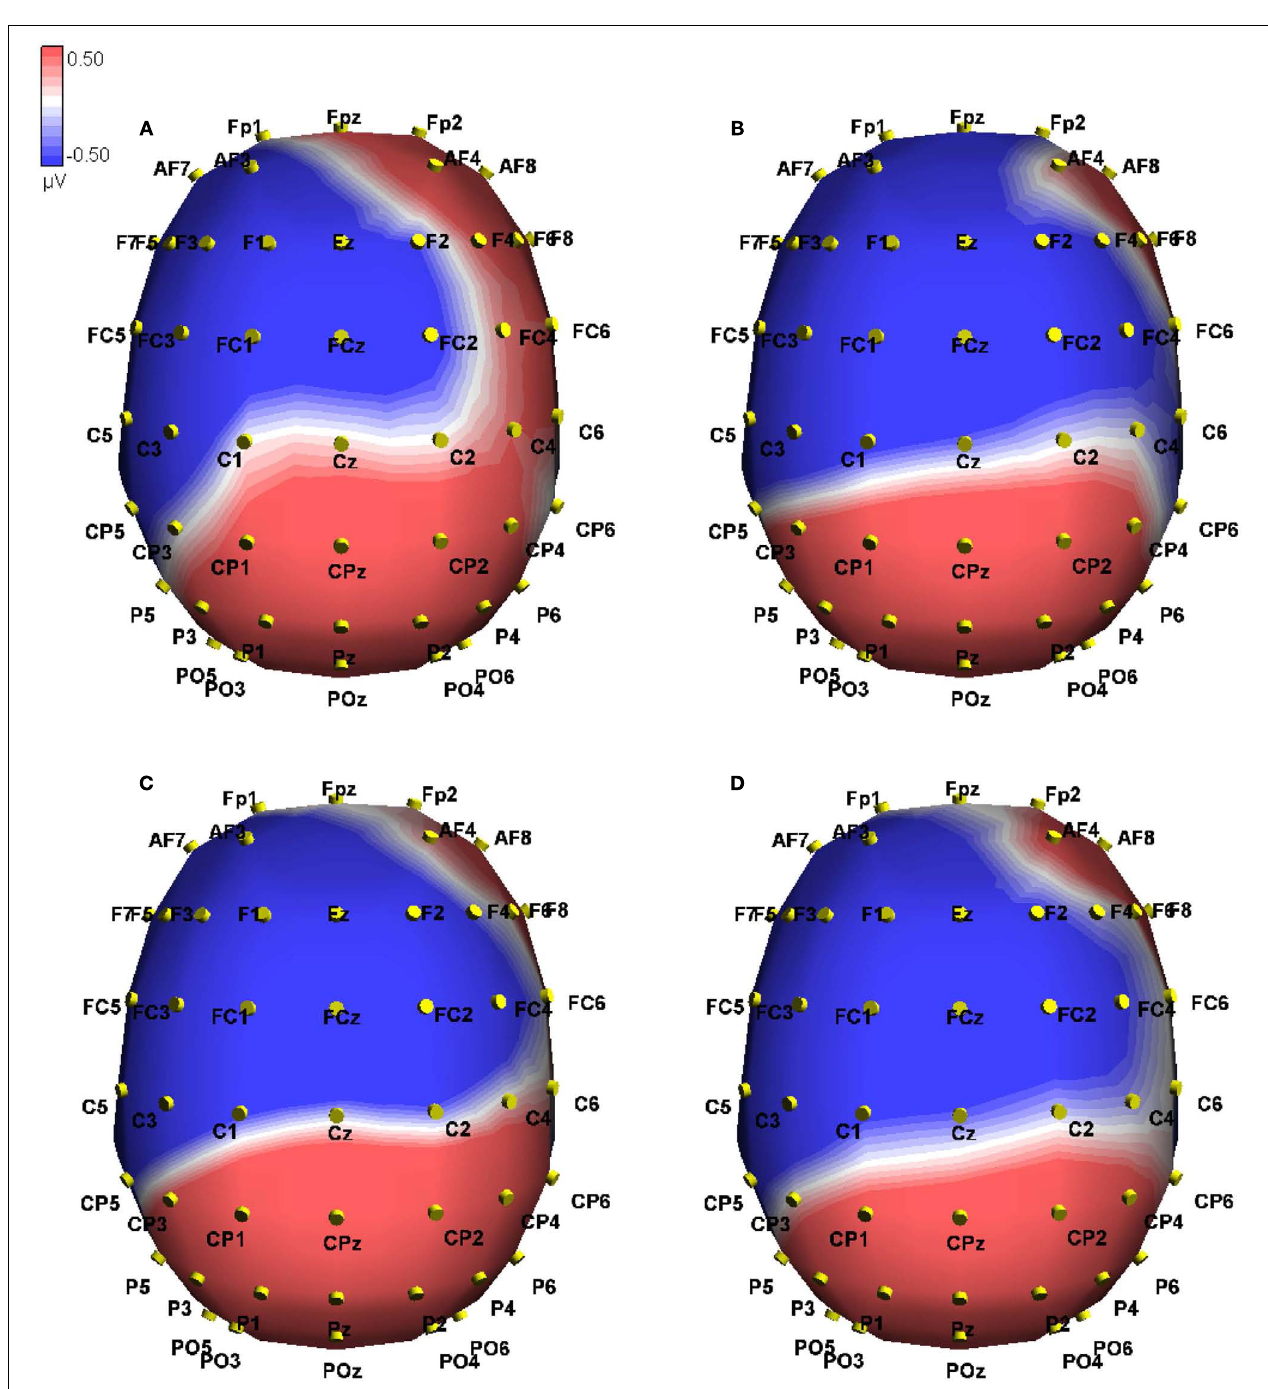
negative potentials, red hues positive potentials.The conditions shown areTrue-Mismatch (A) True-Match (B) , False-Mismatch (C) , and False-Match (D)